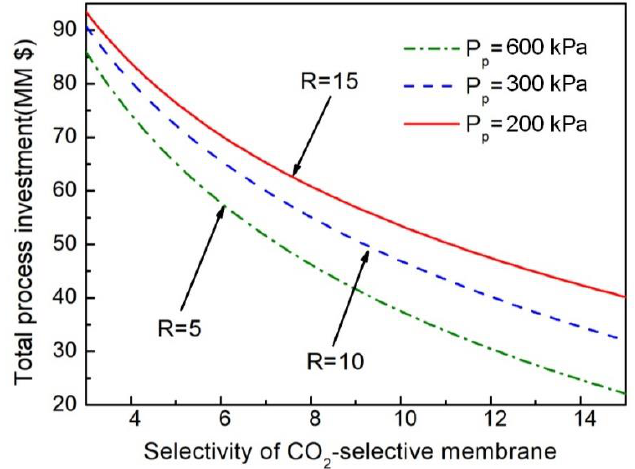
Figure 9. Impact of CO 2 / H 2 selectivity of the CO 2 -selective membrane on total investment cost under different pressure ratios .